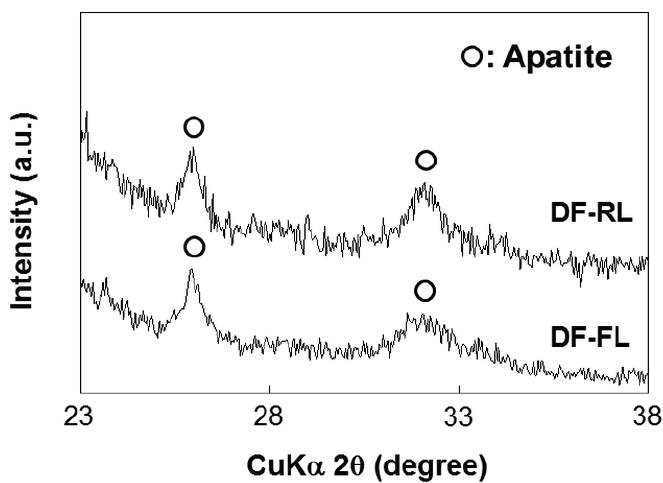
Figure 3. Thin-film X-ray diffraction (TF-XRD) patterns of the surfaces of the DNA–fibronectin–apatite composite layers (DF-Ap layers) immobilizing firefly luciferase ( FL ) gene (Sample DF-FL) and Renilla luciferase ( RL ) gene (Sample DF-RL).